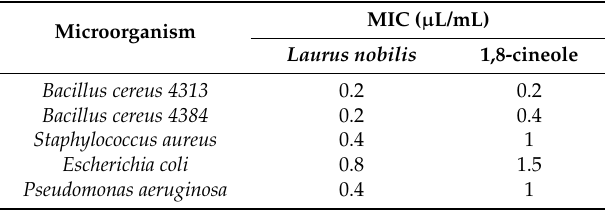
Table 3. Minimal inhibitory concentration (MIC, µL) of the EO of Laurus nobilis and of 1,8-cineole.